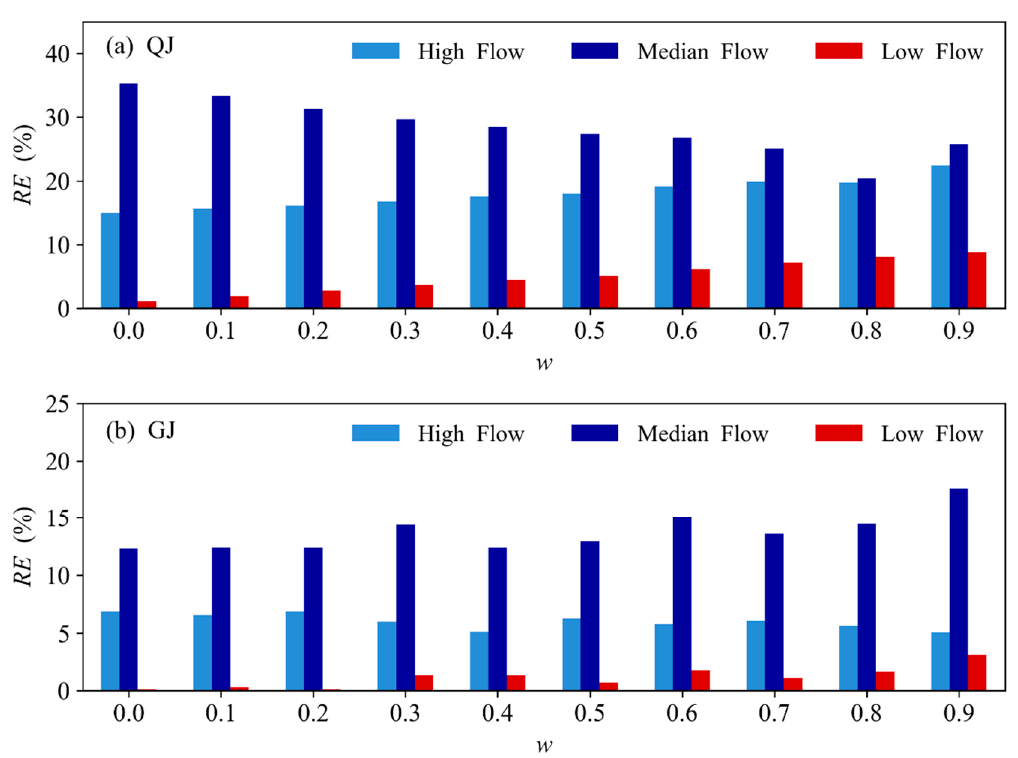
Figure 6. Relative Error ( RE ) in simulated streamflow for ( a ) QJ and ( b ) GJ during the calibration period (2015 – 2017) for three different flow regimes: (Exceedance probability 0 – 10%: high flow; 10% – 60%, medium flow; 60% – 100%, low flow). RE = Abs (Simulated-Observed)/Observed × 100%.